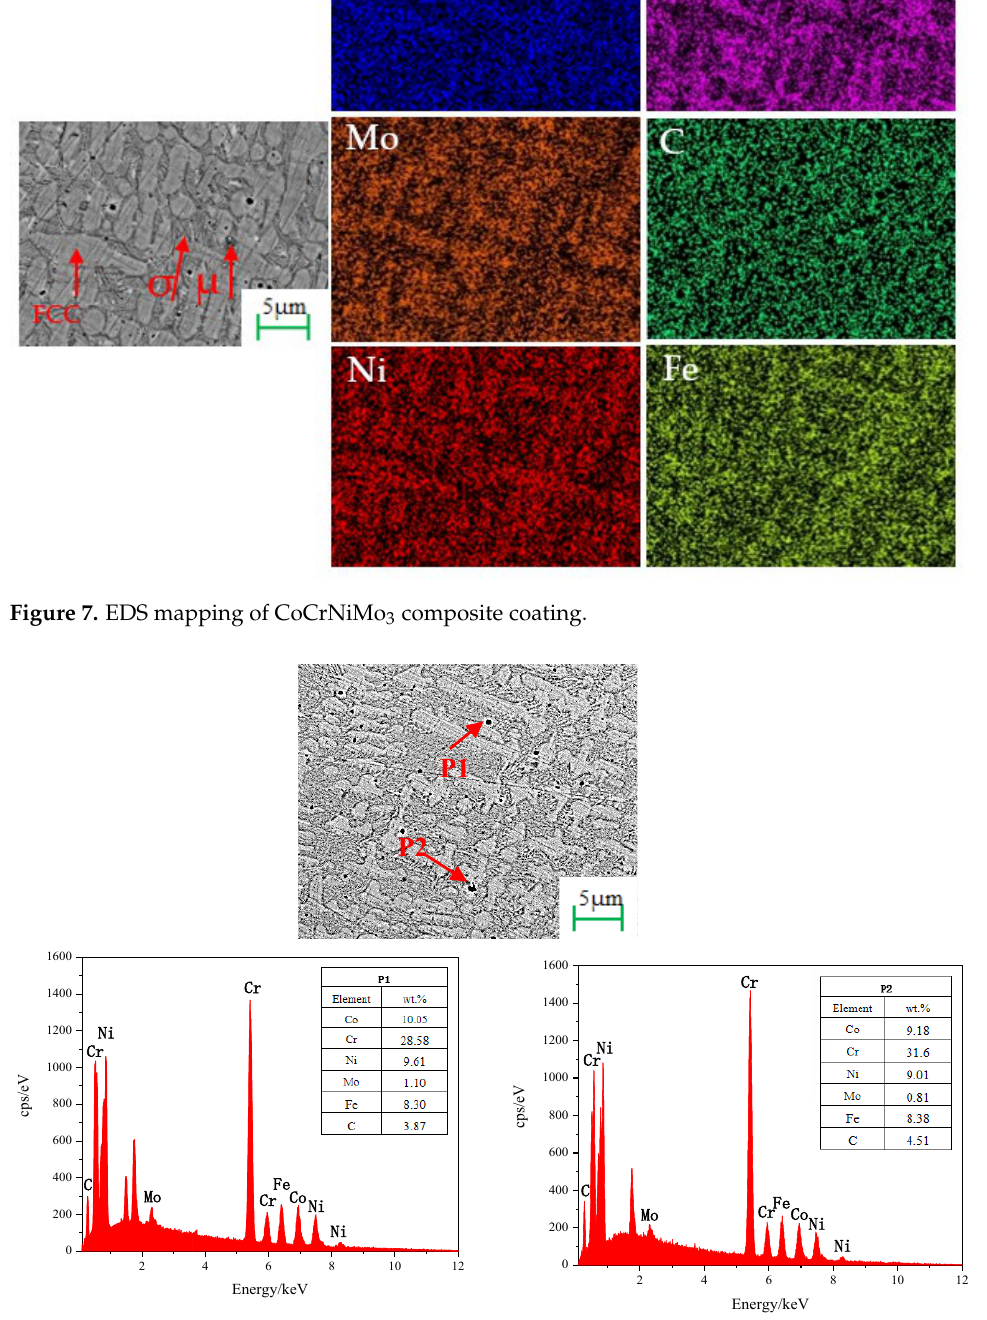
Figure 8. EDS point scanning spectrum of black spots in CoCrNiMo 1 composite coating.